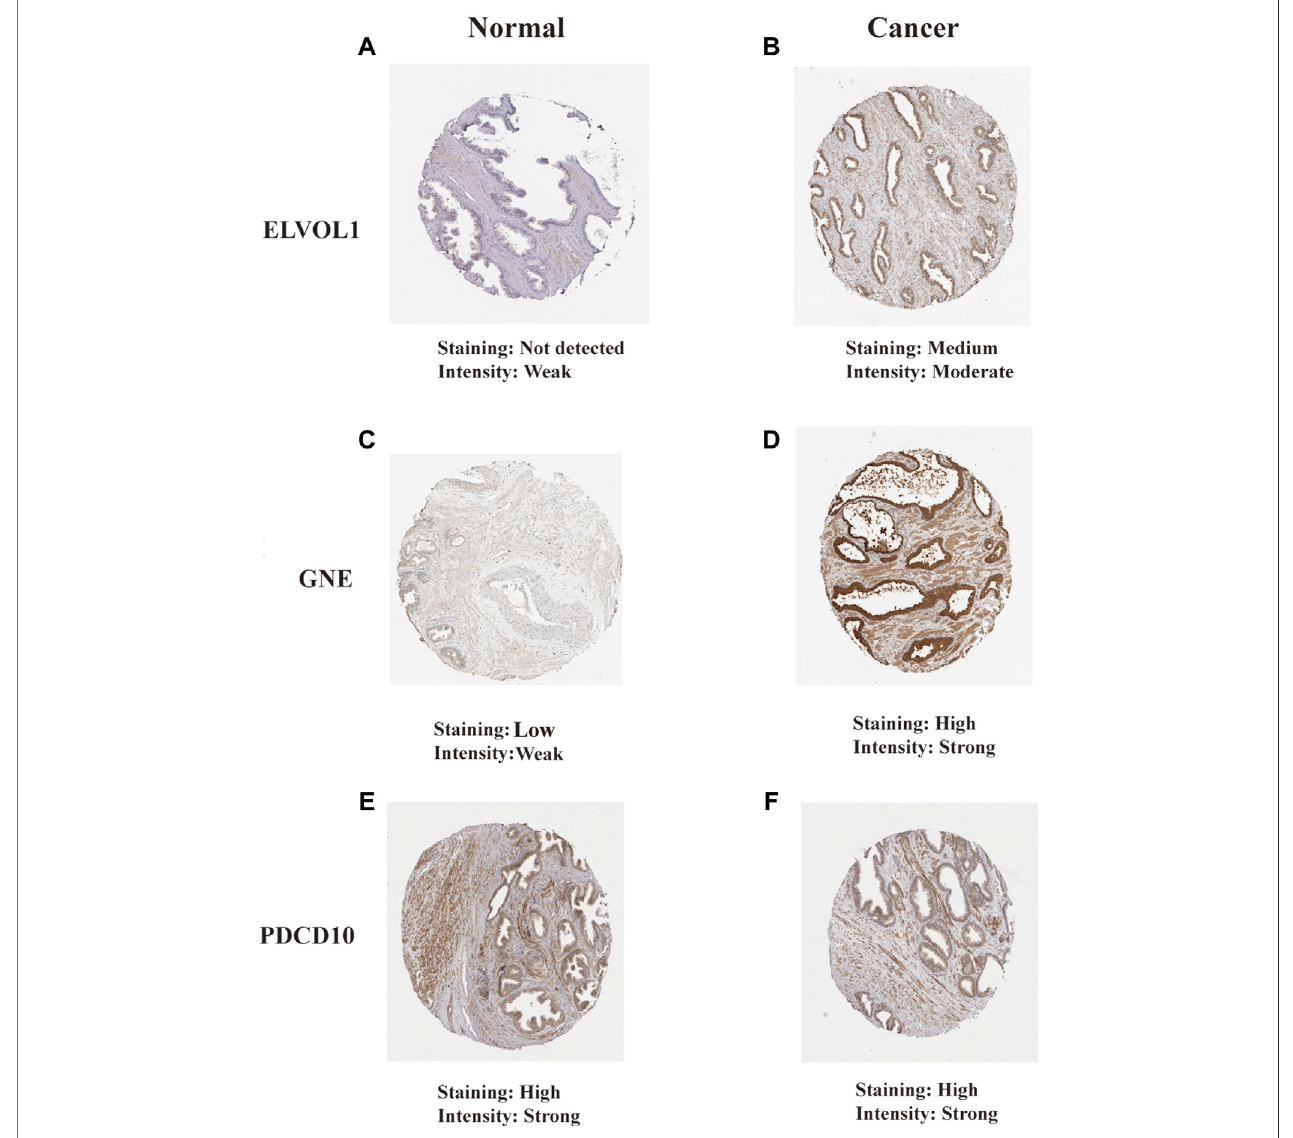
FIGURE 11 | Translational levels of the signature genes in the Human Protein Atlas (HPA) database. (A) ELVOL1 in normal prostate tissue; (B) ELVOL1 in prostate cancer tissue; (C) GNE in normal prostate tissue; (D) GNE in prostate cancer tissue; (E) PDCD10 in normal prostate tissue; and (F) PDCD10 in prostate cancer tissue.